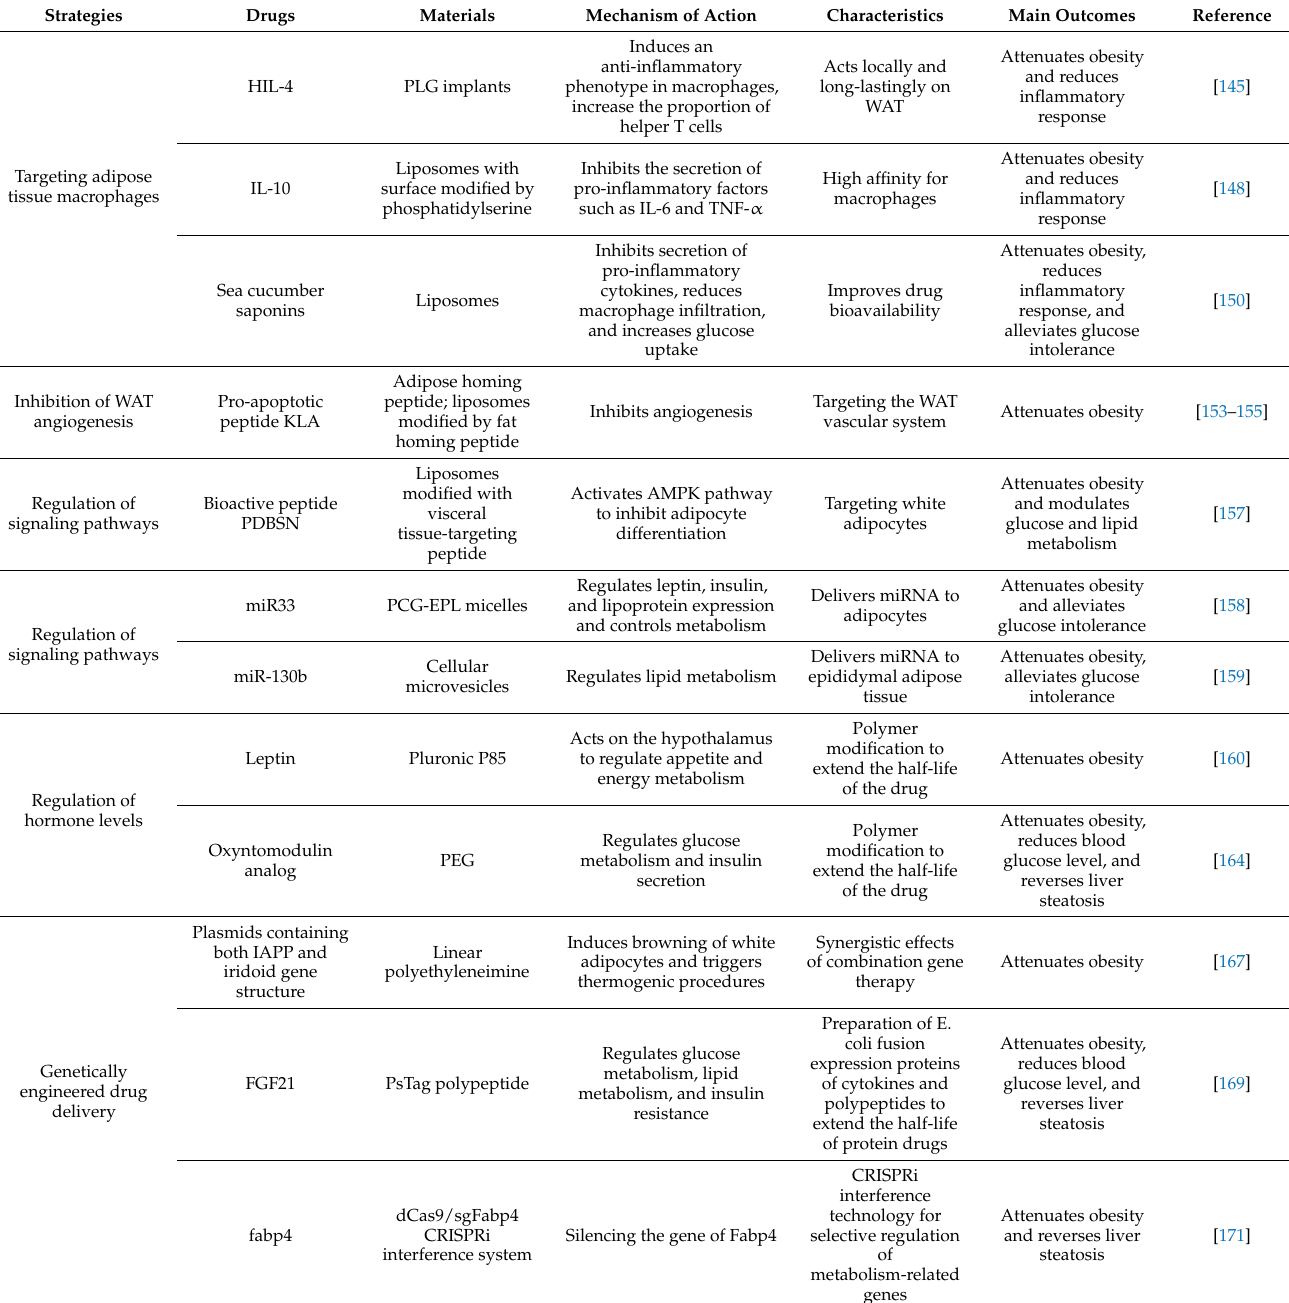
Table 5. Biologic drugs for anti-obesity